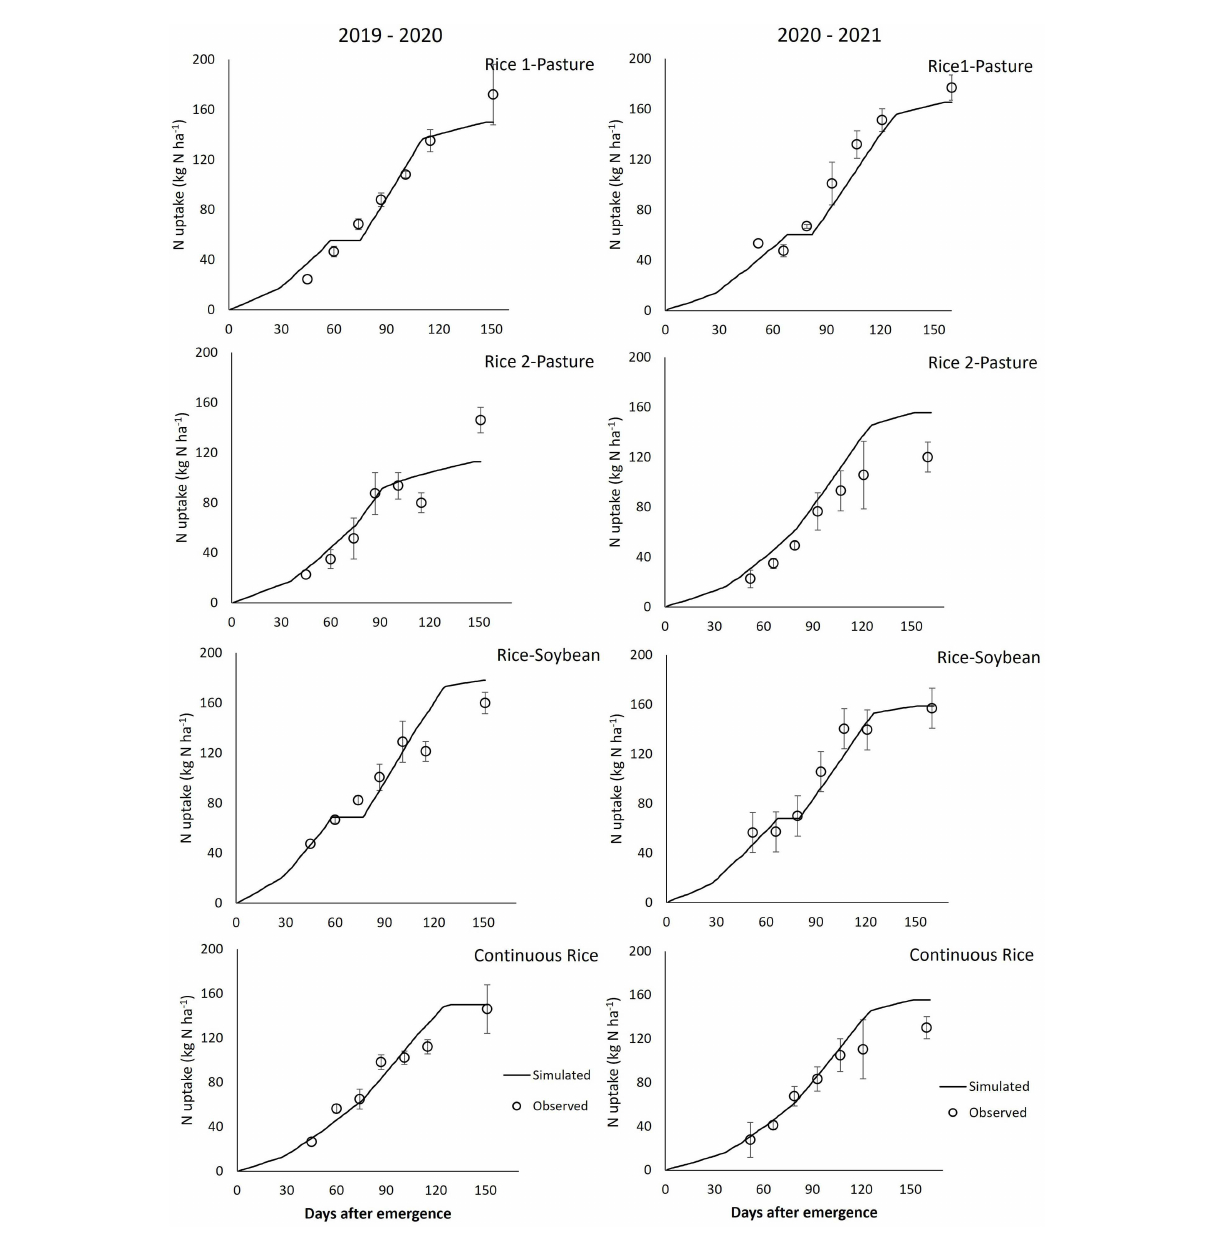
yield ( − 195 kg ha − 1 yr − 1 ) but efficiency indices values